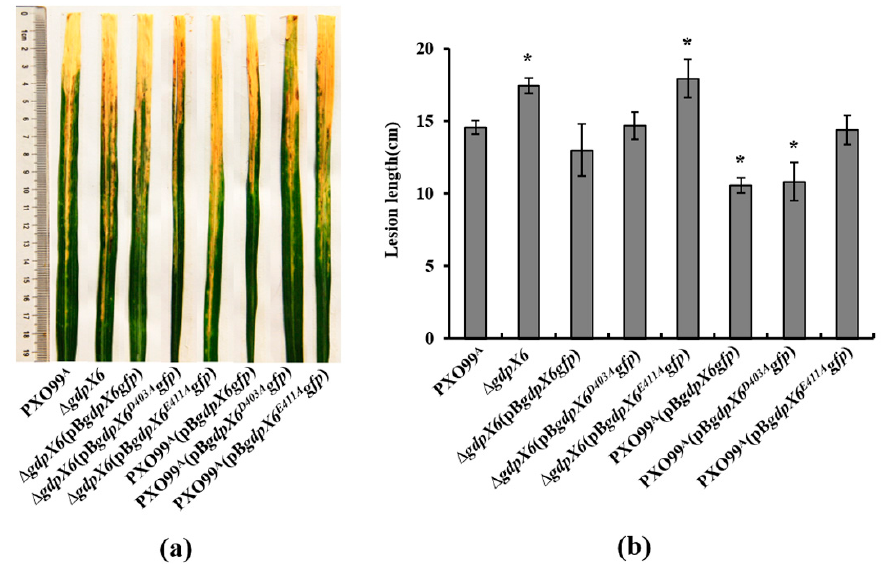
Figure 4. GdpX6 inhibited the virulence of Xoo on rice. ( a ) The bacterial cells were tested on rice by the leaf ‐ clipping method. The disease symptoms were observed at 14 days post ‐ inoculation. ( b ) The lesion lengths were recorded. The error bars represented standard deviations of the lesion lengths from ten leaves. Three independent experiments were performed with similar results. * indicates P < 0.05 as determined by t ‐ test